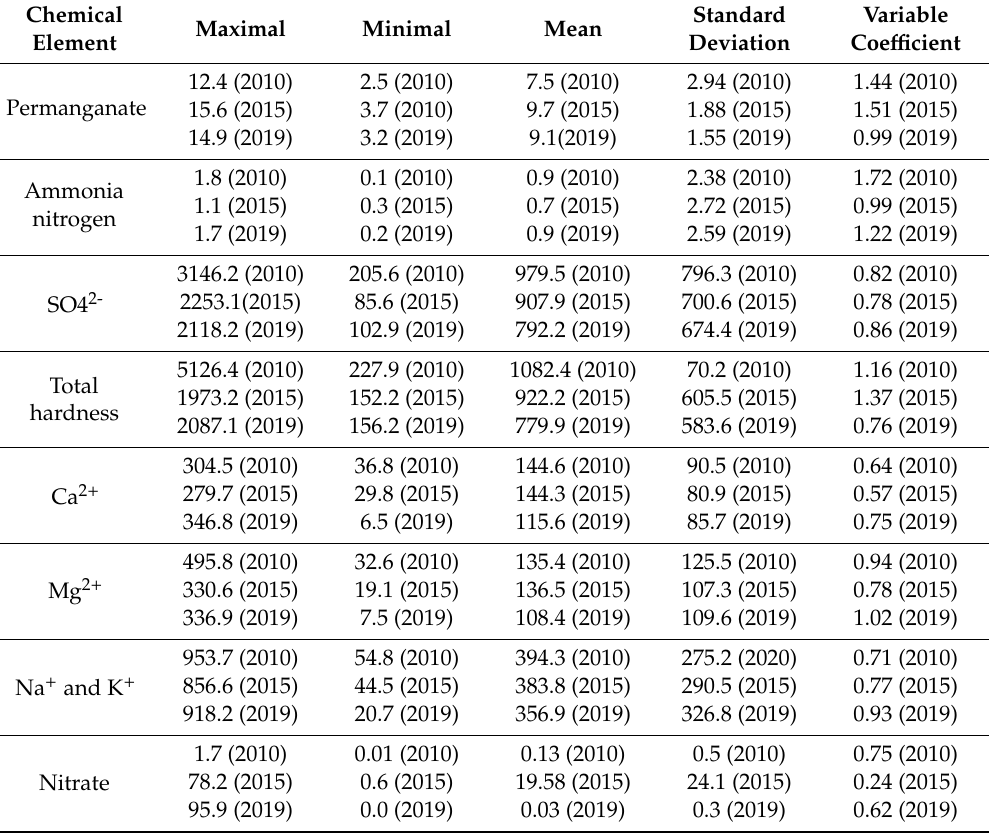
Table 1. Statistical results for water chemical elements of groundwater in selected representative